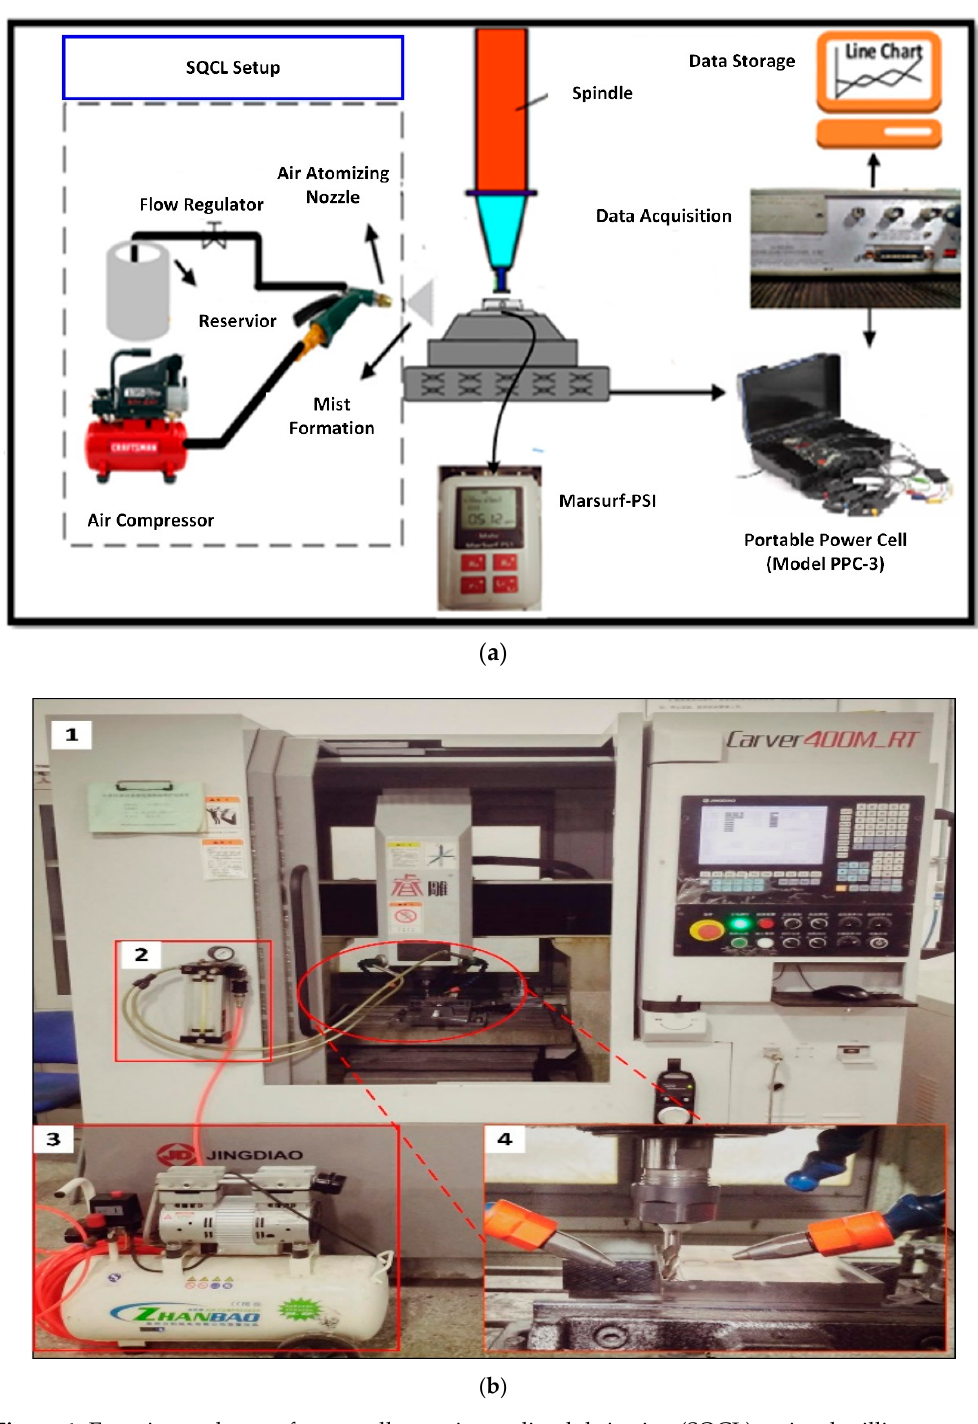
Figure 1. Experimental setup for a small quantity cooling lubrication (SQCL) assisted milling process ( a ) schematic diagram ( b ) Experimental setup